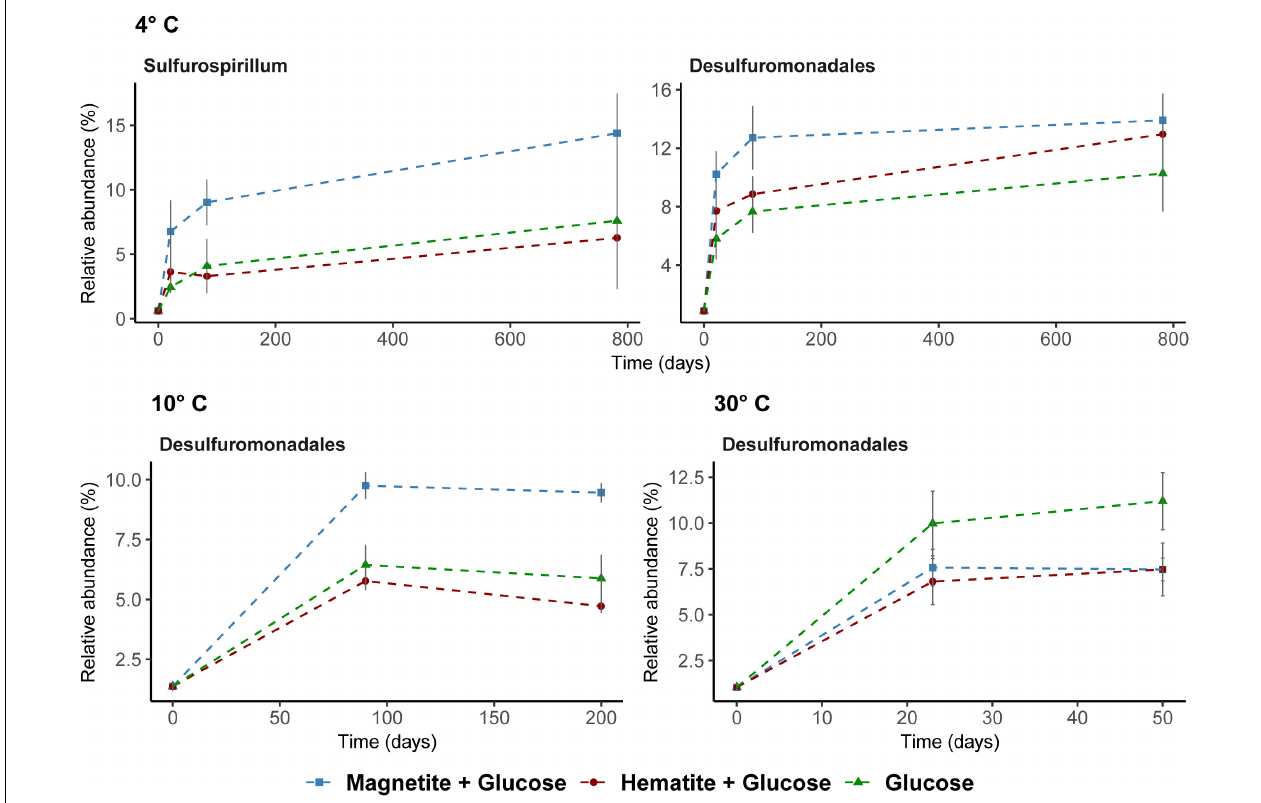
FIGURE 5 | Potential iron reducing bacteria based on 16S rRNA gene analysis across all temperatures. Sulfurospirillum shown at 4 ◦ C only; were below 1% relative abundance at other temperatures.